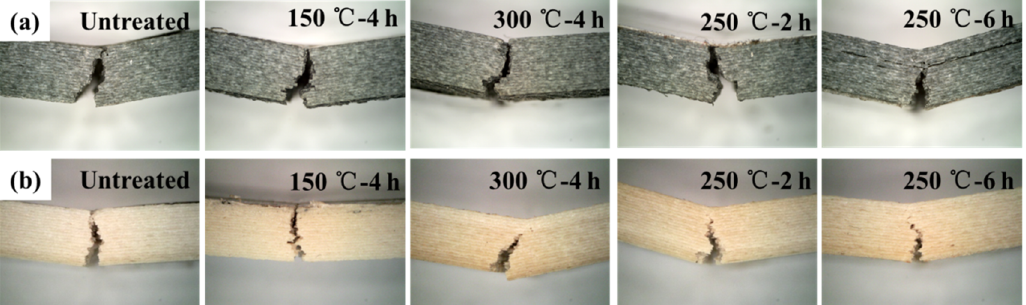
Figure 6. Optical images of interlaminar cracking pattern on the ILSS sample side surface using different heat treatment processes: ( a ) 5 wt% CF/PEEK; ( b ) 5 wt% GF/PEEK.